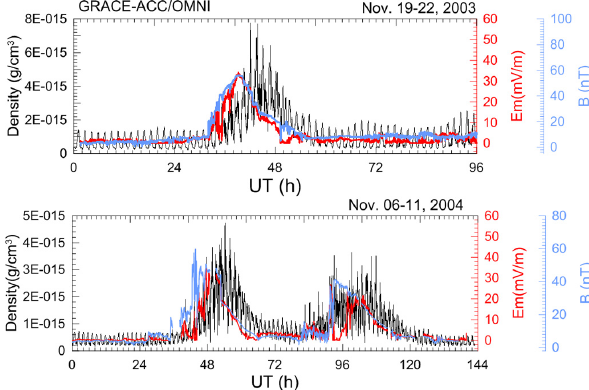
Fig. 2. Temporal variations of GRACE-A observed total mass den- sity, E m and B during 19–22 November 2003 and 6–11 Novem- ber 2004. The black line is for mass density, red for E m and light blue for B